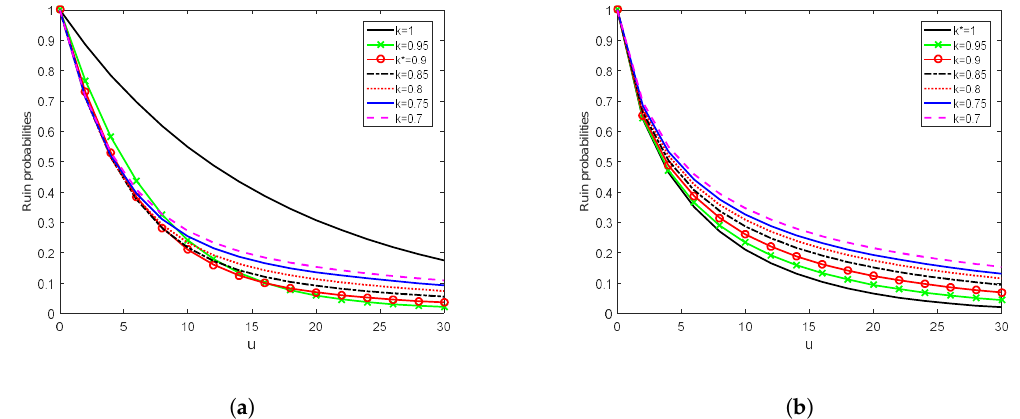
Figure 3. Ultimate ruin probabilities for the diffusion-perturbed model (DPM) compounded by proportional reinsurance; ( a ) DPM with QS reinsurance, Exp(0.5) claims; ( b ) DPM with QS reinsurance, Par(3,2) claims.